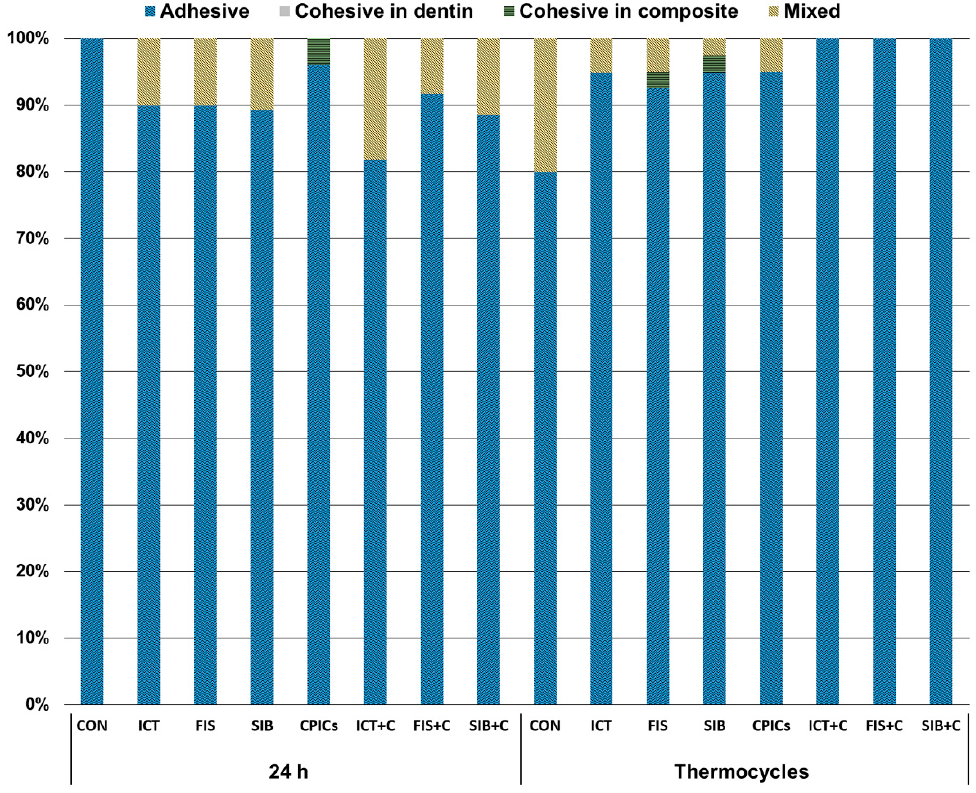
Different superscript letters within each column indicate statistically significant differences (uppercase letters for 24 h and lowercase letters for thermocycling); * There were significant differences in mean values between 24 h and thermocycling.